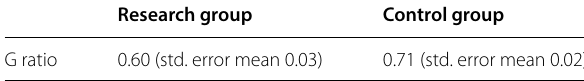
Table 2 Mean value of G ratio for femoral nerve Research group